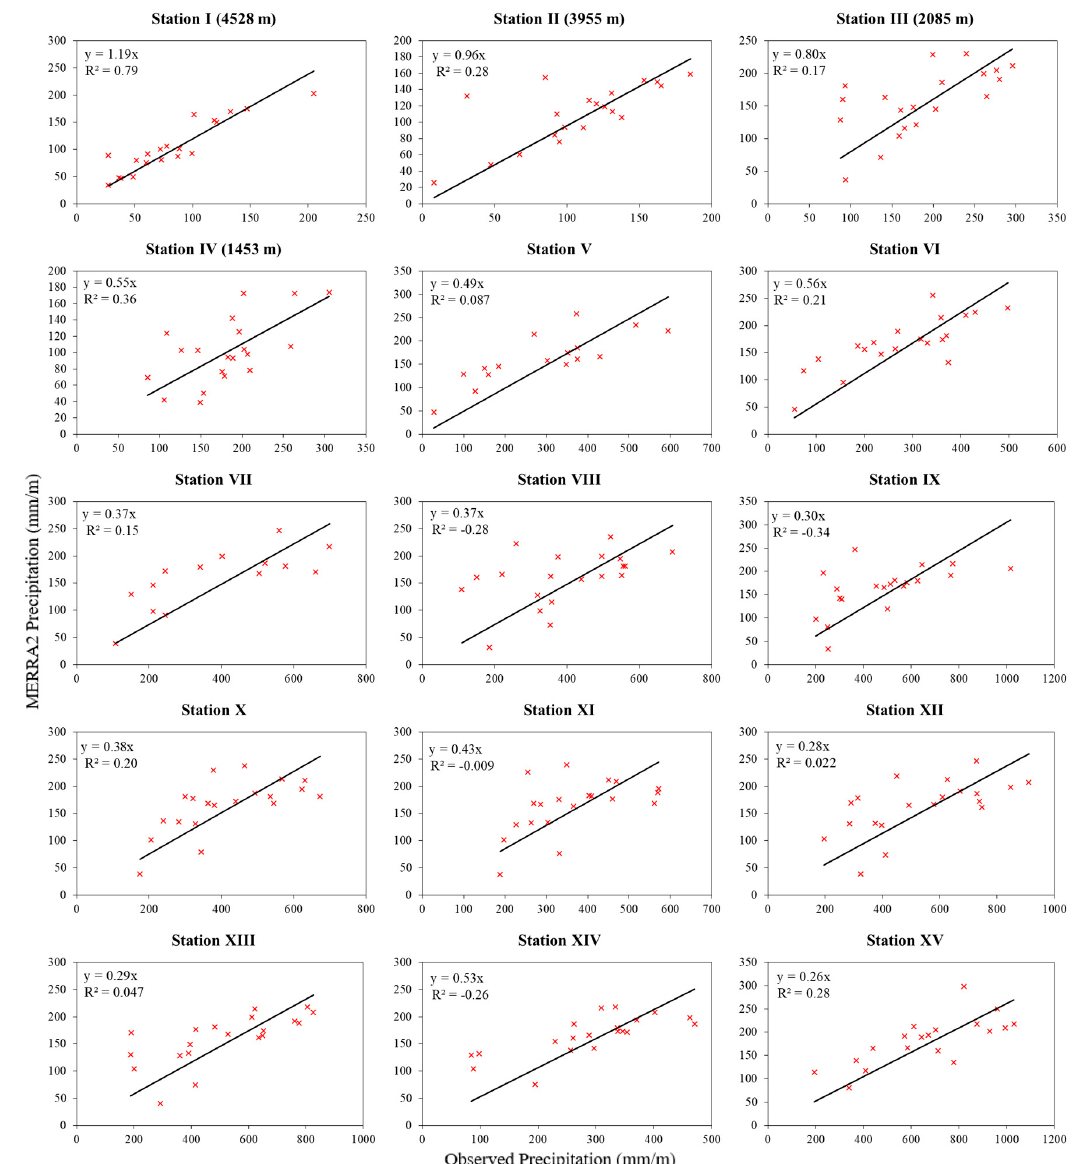
Figure 6. Relationship between the monthly precipitations of Modern-Era Retrospective analysis for Research and Applications, version 2 and observational stations from CMA (I–IV) and Ministry of Water Resources of the People Republic of China (V–XV).